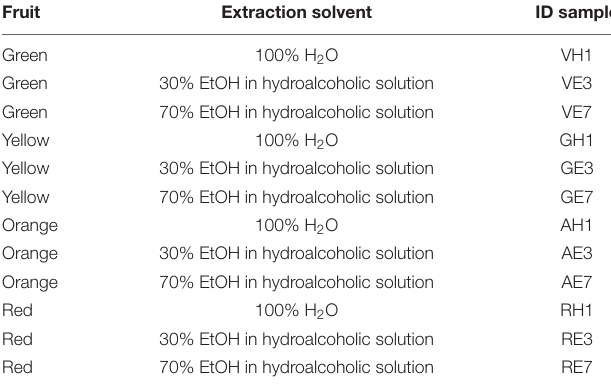
TABLE 1 | A. unedo fruit extract samples subjected to analysis.